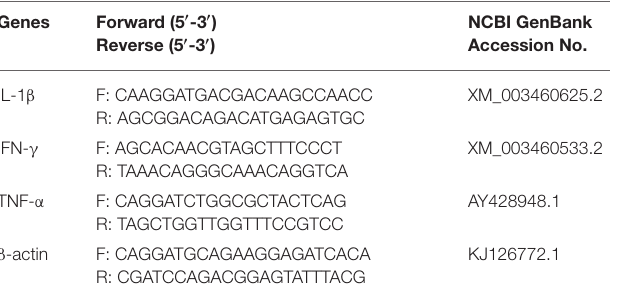
TABLE 2 | Primers sequences used for real-time quantitative PCR (qPCR) analysis.